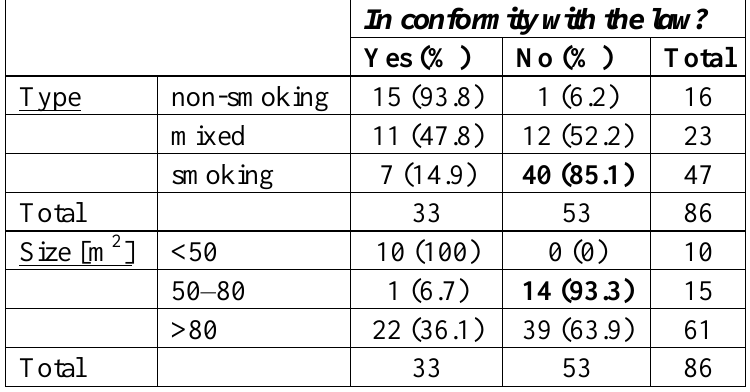
Table 2. Number and percentage of venues complying with the law. Frequent non-compliance in exclusive smoking venues and those with a salesroom size of 50 to 80 m 2 (bold figures).